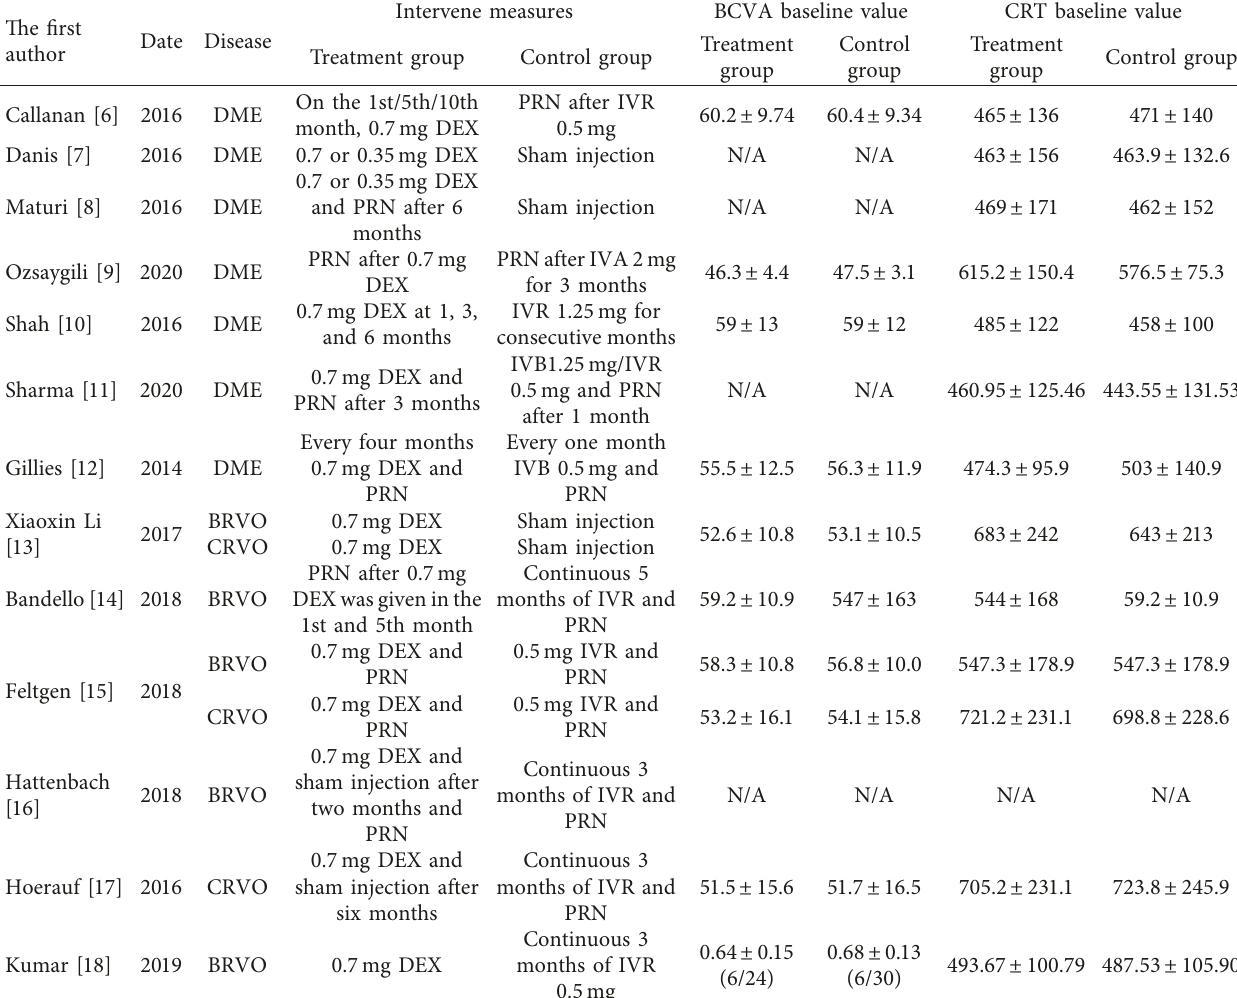
Table 1: Characteristics of included studies.